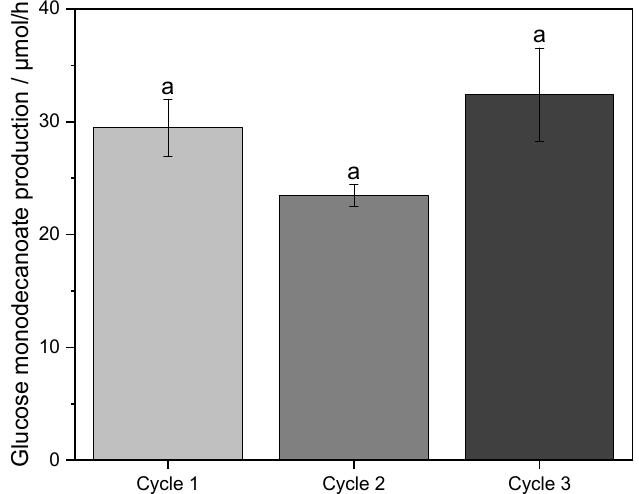
Figure 5. Recycling of the aqueous phase. Glucose containing aqueous phase was reusable as glucose feed solution over at least three cycles. a, b show statistically significant differences (one-way ANOVA, Tukey’s test, p < 0.05).